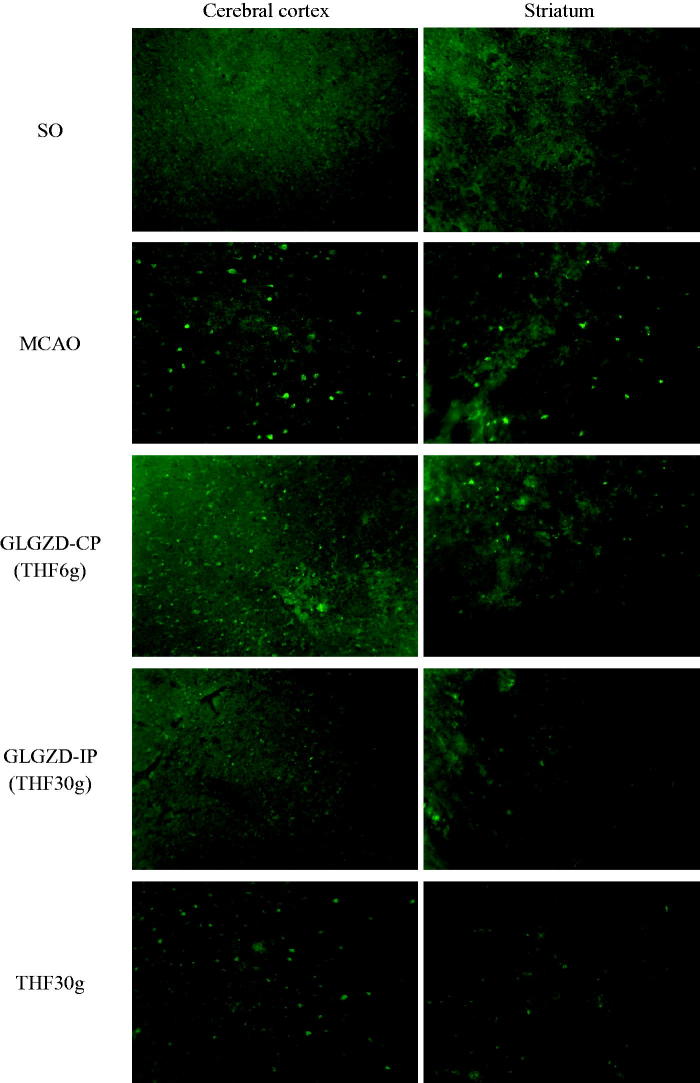
Fluorescence micrographs of [Ca2+]i in cerebral cortex and striatum neurone of MCAO rats (100×).